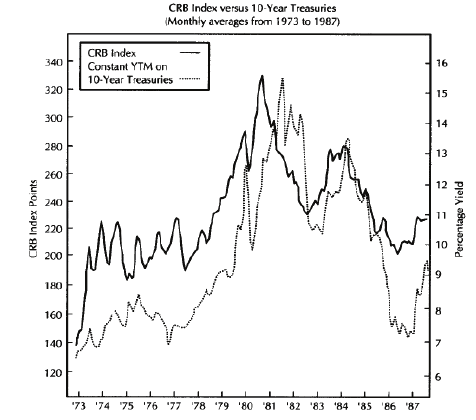
Fig. 2 – A demonstration of the positive correlation between the TR/J CRB index and 10-year Treasury yields from 1973 to 1987. Source: Murphy